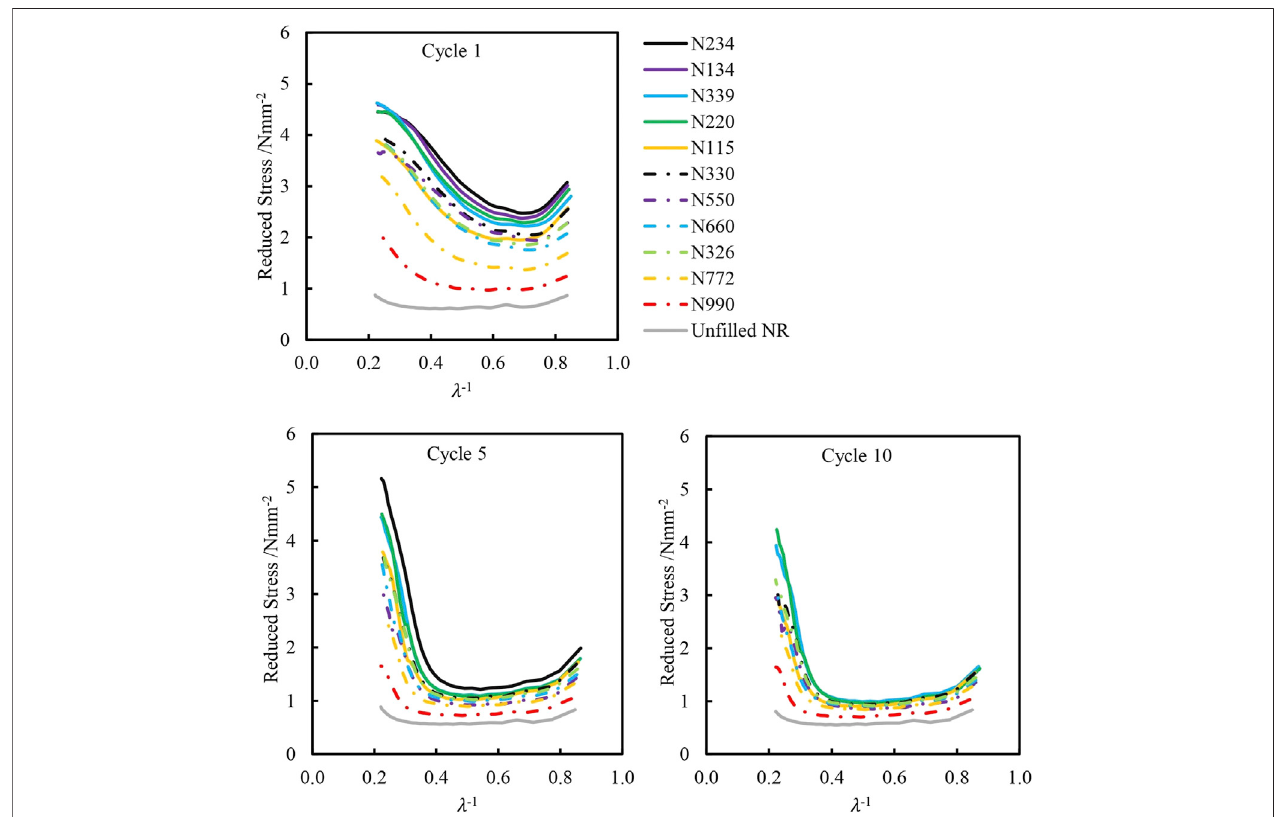
FIGURE 4 | Mooney-Rivlin plots of carbon black reinforced and unreinforced natural rubber extended to 350% strain on cycles 1, 5 and 10.